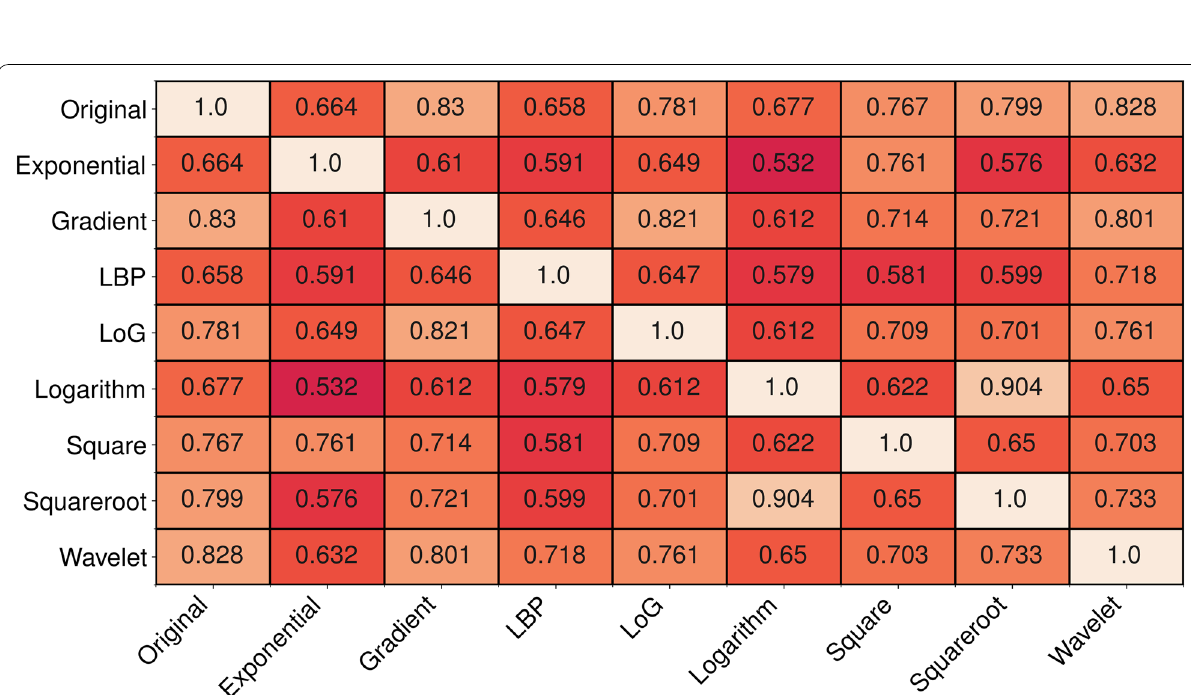
Fig. 4 Mean correlation between feature sets. In each cell, the mean pairwise Pearson correlation coefficient ( r ) between features of the corresponding two feature sets is